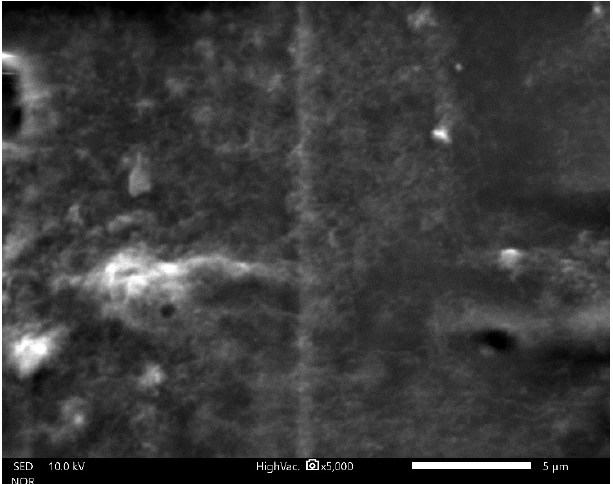
Figure 5. SEM image of the surface of the PLA/CNT nanocomposite foil (2% by weight content).